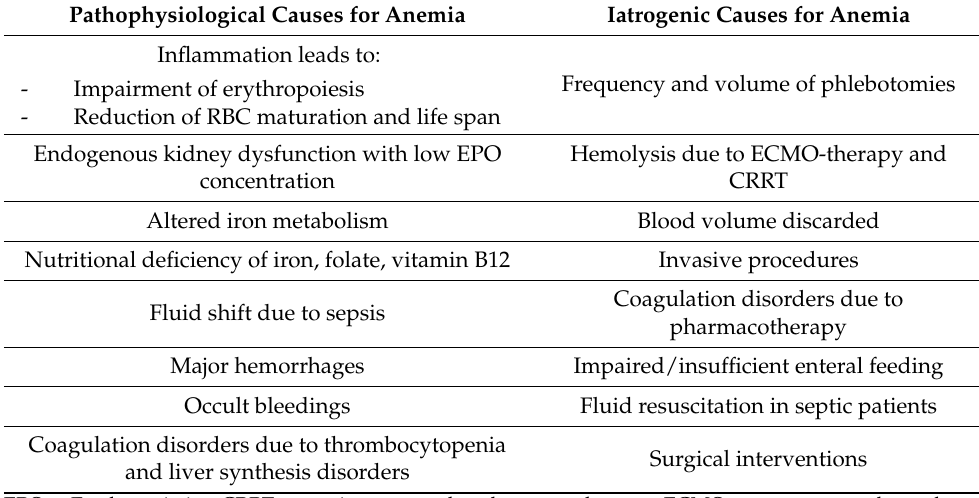
Table 1. Causes for anemia in critically ill